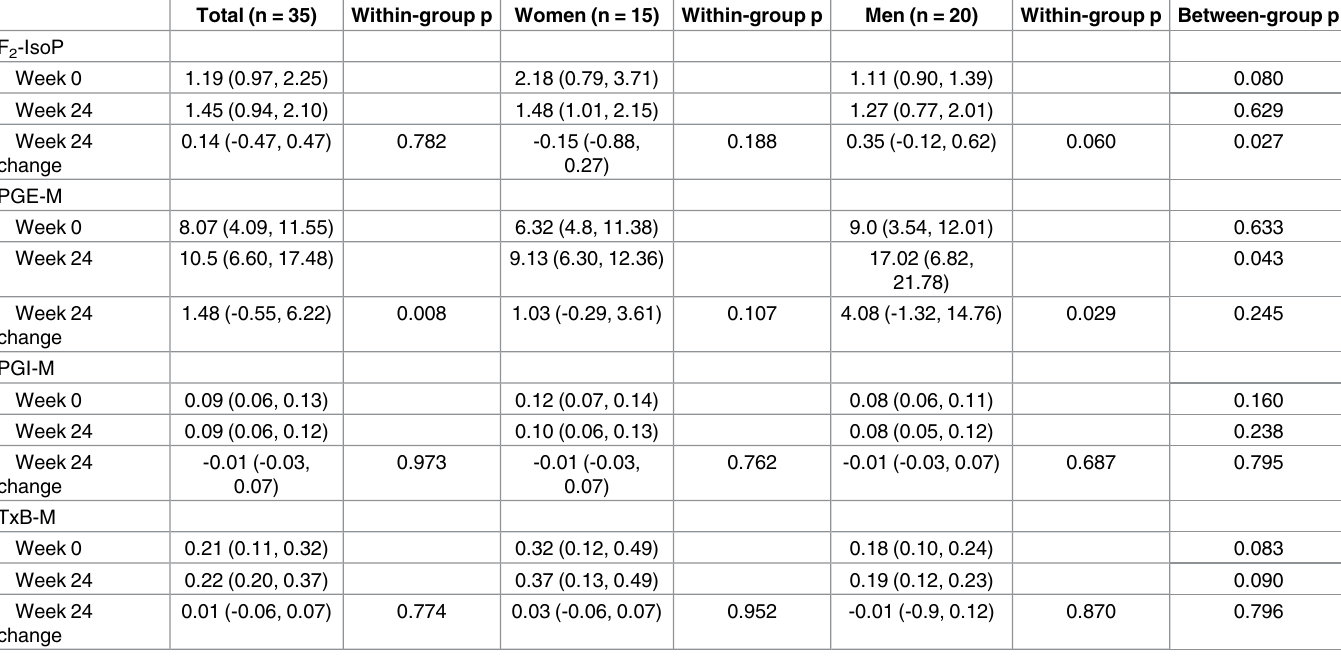
Table 2. Absolute and 24-weekchanges in urinary eicosanoid levels by study arm (median with interquartile range). Total (n = 35) Within-group p Women (n = 15) Within-group